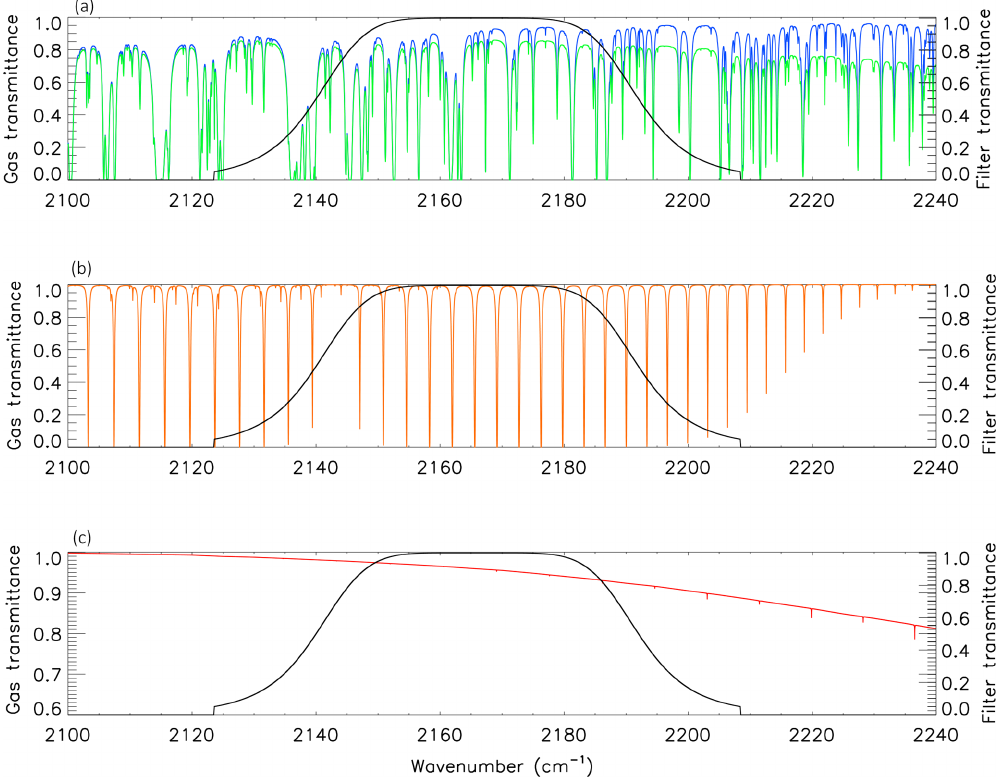
Figure 4. Top-of-atmosphere spectral transmittances for water vapor (a) , CO (b) , and nitrogen collisionally induced absorption (c) near the MOPITT TIR passband. Panel (a) compares differences in water vapor absorption calculated with MT_CKD version 1.0 (in blue), used in previous MOPITT forward models, and MT_CKD version 3.2 (in green), used for V8. Panel (c) indicates collisionally induced absorption by nitrogen, which is represented in V8 forward modeling for the first time. The MOPITT TIR passband is indicated in black in all three panels. Table 1. Radiance bias correction parameters used for processing MOPITT version 8 retrieval products. See Sect. 2. R 0 is